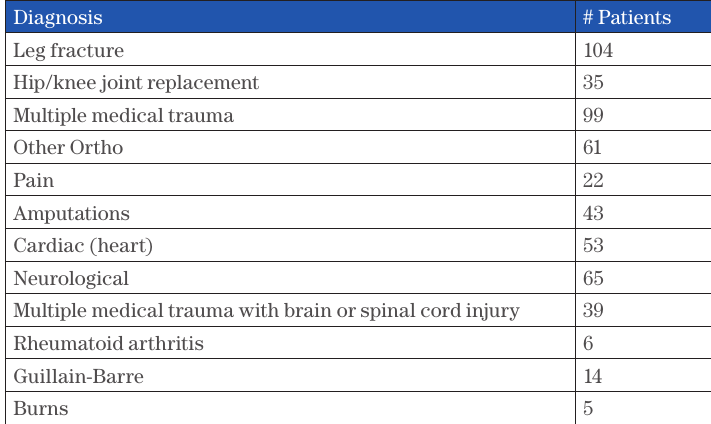
Table 1. The most common diagnosis of patients participating in